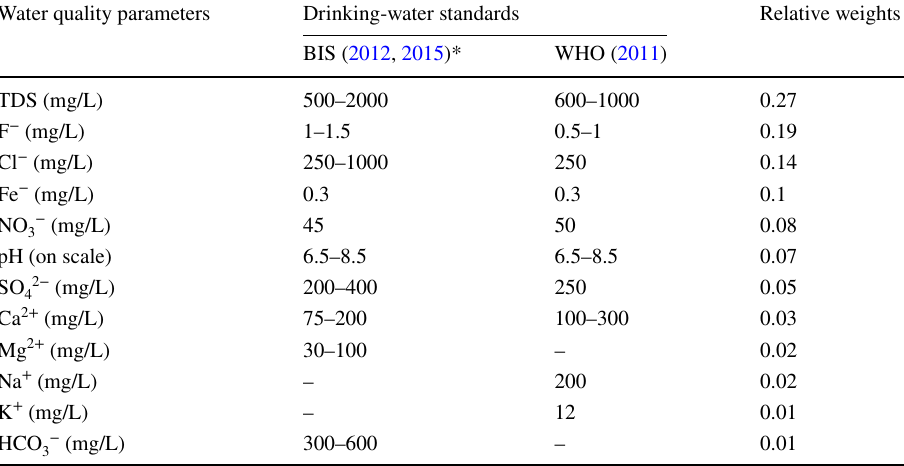
Table 3 Groundwater quality standard and relative weights